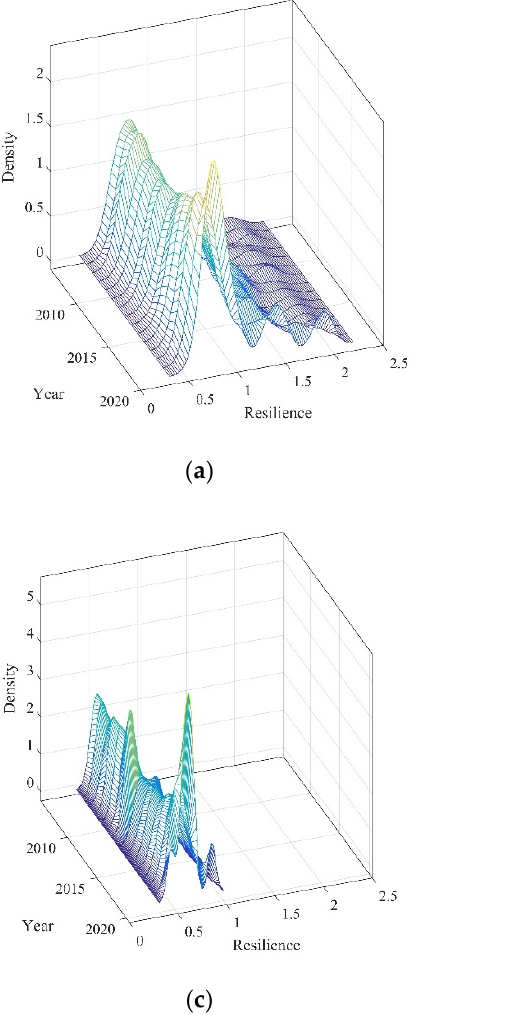
Figure 6. Dynamic distribution of the livelihood resilience of rural residents in three regions of China, and overall: ( a ) China-overall; ( b ) Eastern; ( c ) Central; ( d ) Western. Note: The lighter the color, the greater the density. Source: the authors’ own work.